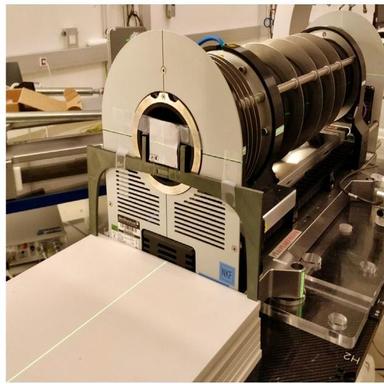
Relative range measurements of four textiles in comparison to Pb, Al, and only water (i.e. empty). The proton range is defined at the 80% fall-off behind the Bragg peak. Details on the space suit materials are listed in.